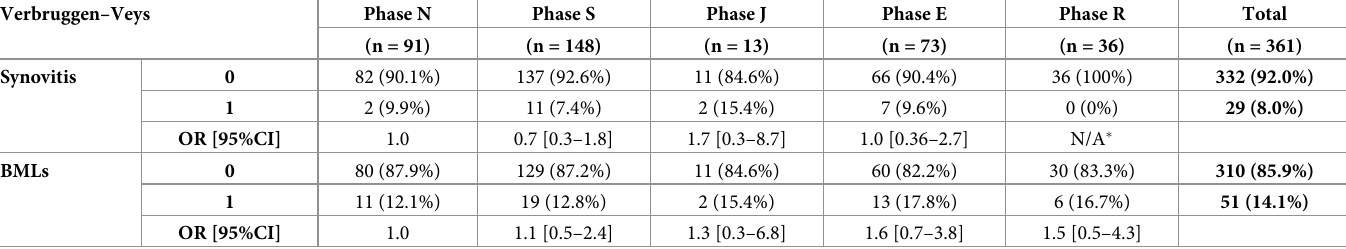
Joints with E/O and D presented significantly more synovitis and BMLs than did normal joints (Table 6). For E/O and D, the odds ratios for synovitis were 8.4 (95% CI 1.8 to 13.6; p = 0.017) and 13.7 (95% CI 2.9 to 21.0; p = 0.001), respectively. The same observation was made for BMLs: E/O: OR 15.7 (95% CI 3.2 to 23.5; p < 0.001) and D: OR 38.5 (95% CI 9.5 to 57.0; p < 0.001). Table 5. The agreement and the ORs (95% CI) between synovitis, BMLs and Verbruggen-Veys radiographic scoring system features of the interphalangeal joints of the 2nd–5th fingers.